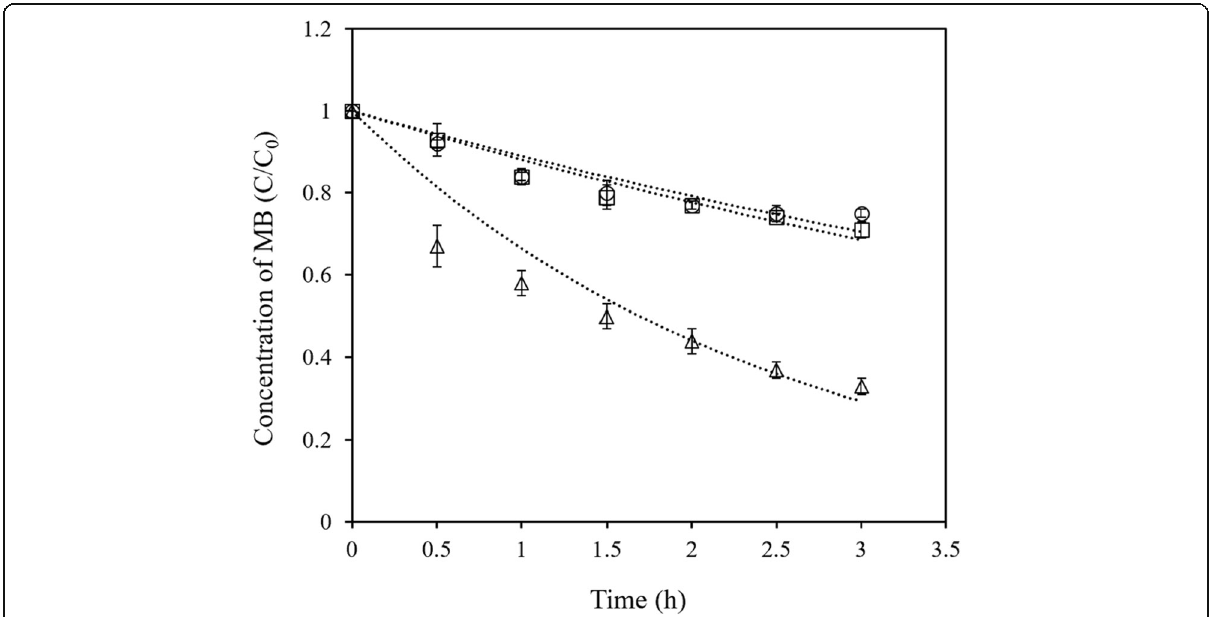
Fig. 5 Electrochemical degradation efficiencies of MB with various anodic electrode materials in solution under an applied current of 50 mA, electrolyte of 0.1 M H 2 SO 4 , initial MB concentration of 10 mg L − 1 , initial pH value of the solution of 1.83 and cathode of CNTs/CF M . Δ : CNTs/CF M ; □ : CF ○ : CF M ;